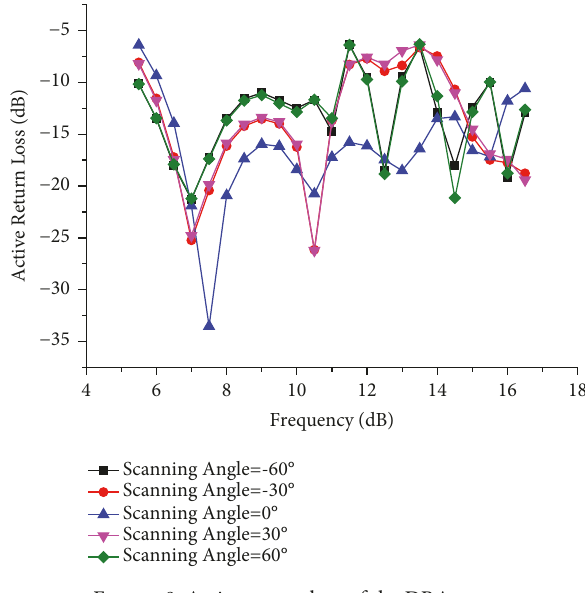
Figure 8: Active return loss of the DRA array.